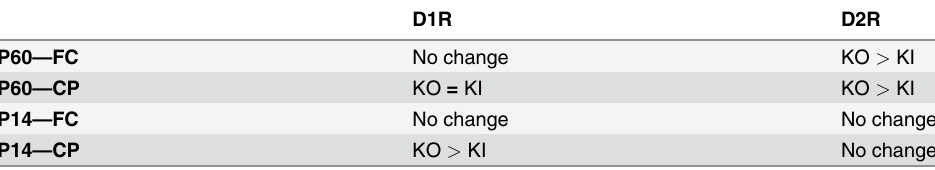
A comparison of the magnitude of reductions in D1R and D2R protein expression in the frontal cortex (FC) and caudate putamen (CP) of postnatal day 60 (P60) and postnatal day 14 (P14) Dyt1 KO (KO) and Dyt1 KI (KI)